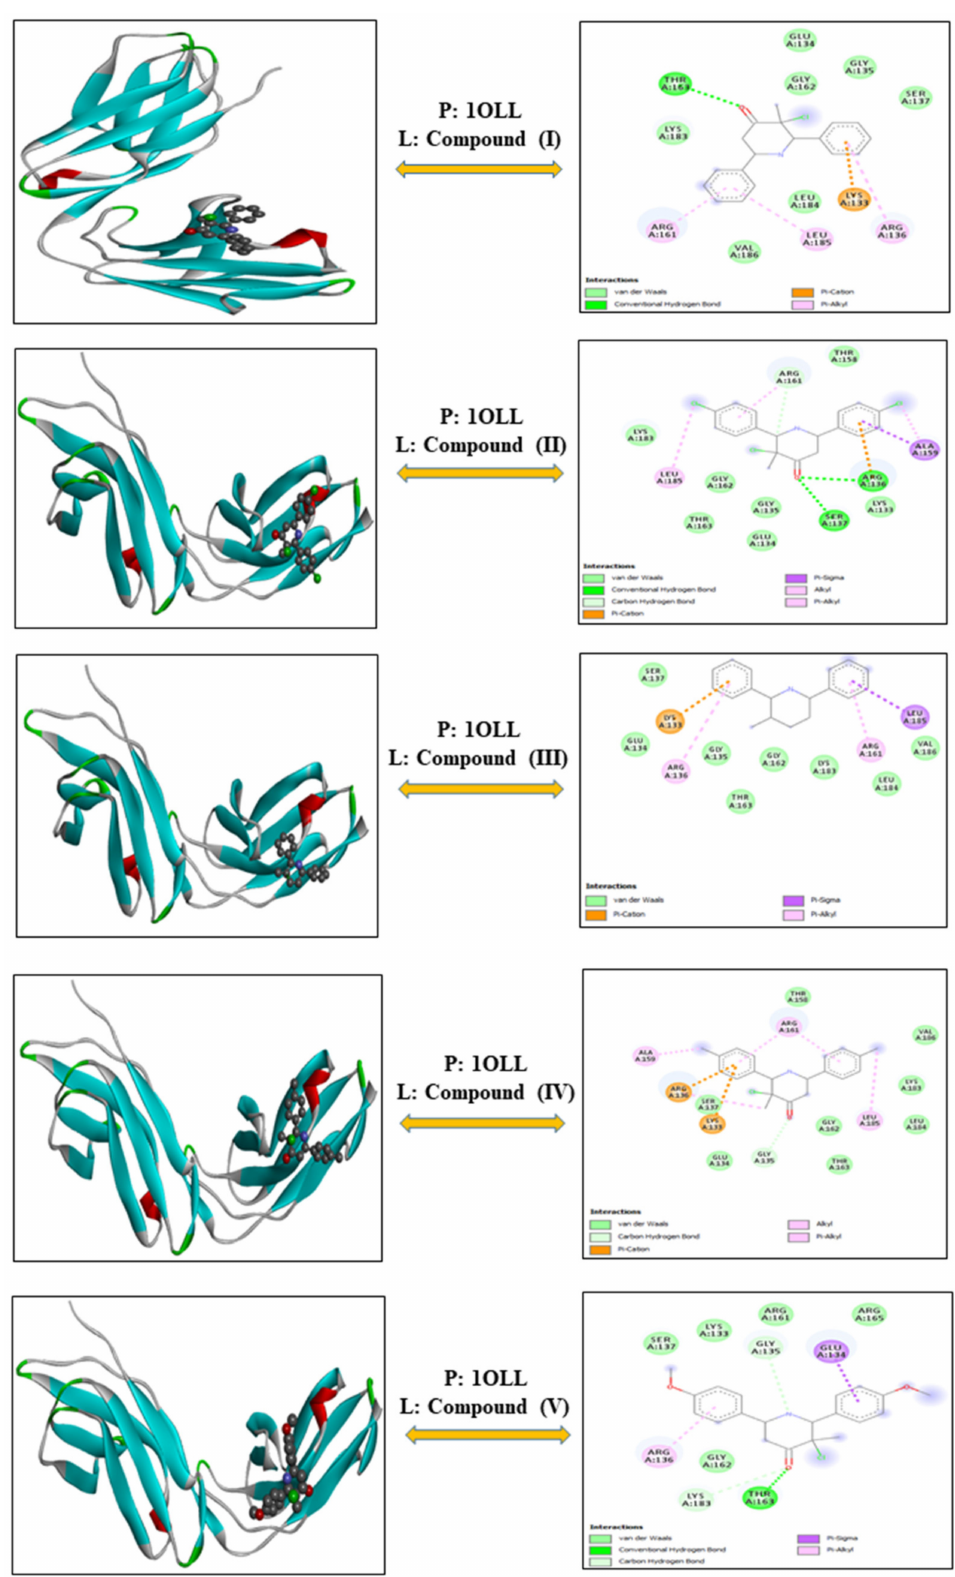
Figure 5. Compounds I – V (ligands) and 1OLL (protein) are all best-docked positions, and the right side shows the lowest-energy 2D